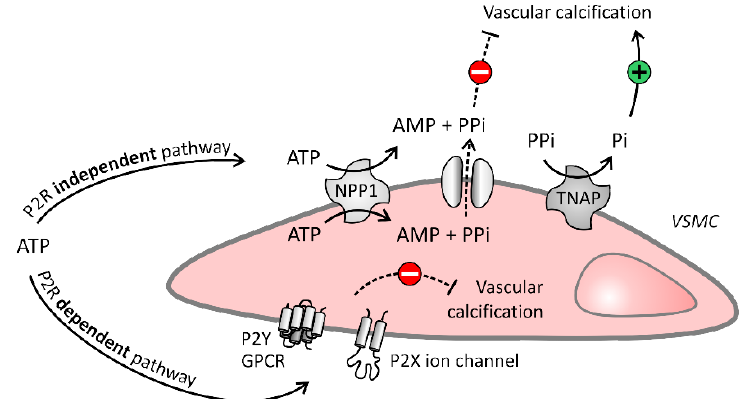
Figure 2. Purinergic independent and dependent signaling in the vascular cell. Purinergic receptor (P2R) independent pathway: Vascular cells degrade ATP into adenosine monophosphate (AMP) and pyrophosphate (PP i ) by ecto-nucleotide pyrophosphatase / phosphodiesterase (NPP1). The potent calcification inhibitor PPi blocks arterial calcification, however, PP i itself can also be broken down into the calcification stimulator inorganic phosphate (P i ) by tissue non-specific alkaline phosphatase (TNAP). P2R dependent pathway: ATP also inhibits arterial calcification by interaction with P2 receptors, being P2Y and P2X receptors, expressed on the extracellular membrane of vascular cells. Solid and dashed arrows represent respectively stimulatory and inhibitory arrows.